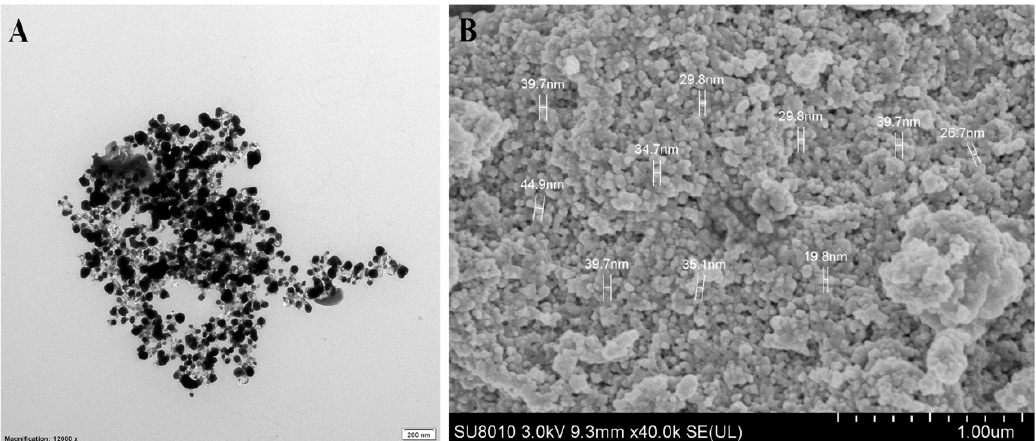
Figure 9. Size and morphology of silver nanoparticles (AgNPs) that were synthesized by reducing 3 mM AgNO3 by using culture filtrates of the endophytic bacterium P. poae strain CO. ( A ) Transmission electron microscopy and ( B ) scanning electron microscopy.